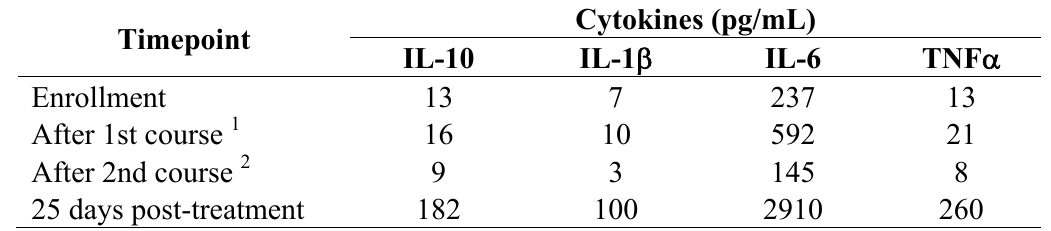
Table 5. Cytokine response of PBMC from a breast cancer patient stimulated with lysates of the breast cancer cell line,